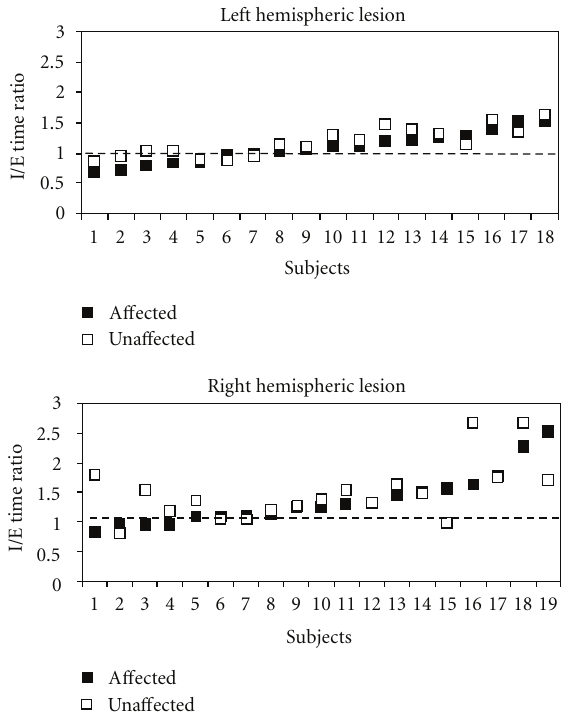
Figure 3: Illustration of individual I/E time ratio for the a ff ected and una ff ected sides in each subgroup of patients.